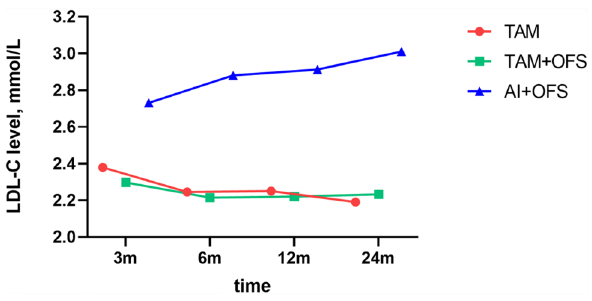
Figure 3. Low-density lipoprotein cholesterol (LDL-C) levels over